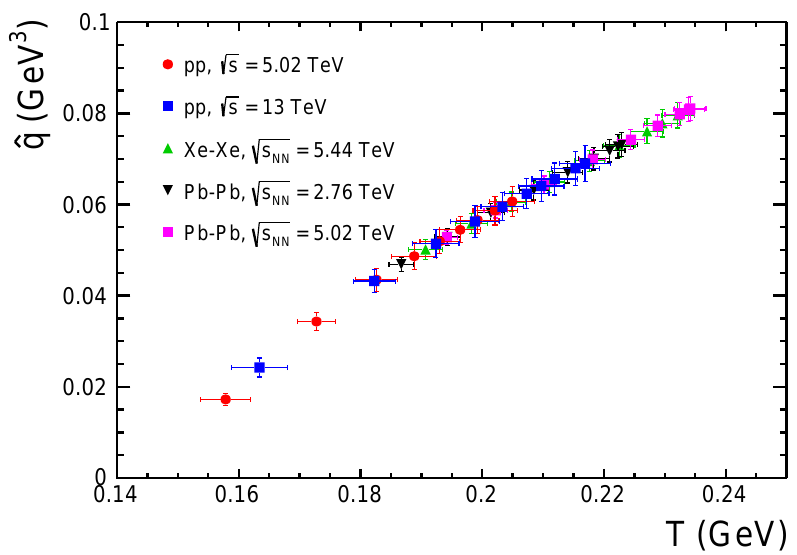
Figure 3. Jet quenching parameter, ˆ q , as a function of temperature within the color string percolation √ s = 5.02 and 13 TeV, Xe-Xe collisions at model (CSPM) for pp collisions at √ s NN = 2.76 and 5.02 Pb-Pb collisions at